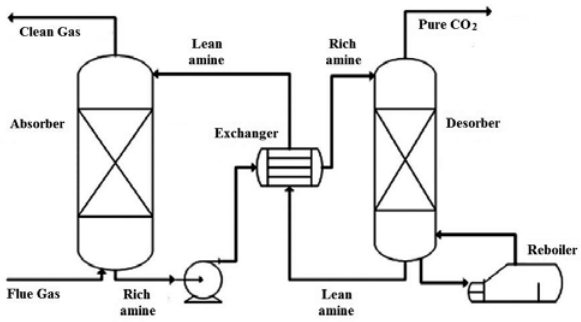
Figure 3. A simplified flow sheet for the CO 2 removal